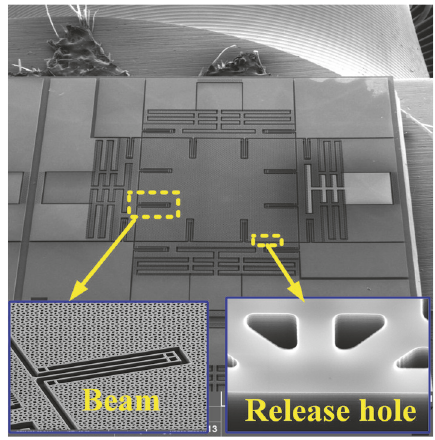
Figure 7: SEM of the